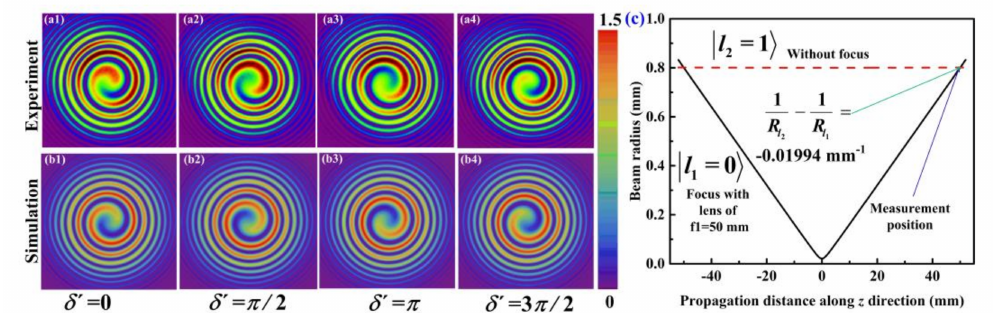
Figure 2. Effect of the effective phase difference δ (cid:48) between the Gaussian beam ( | l 1 = 0 (cid:105) ) and the vortex beam ( | l 2 = 1 (cid:105) ) on the lobe direction. Images ( a , b ) show interference patterns; Row ( a ) shows the experimental results, and row ( b ) shows the simulation results. The color bar is shown for numerical simulation. ( c ) shows the beam radii of two interference beams versus the propagation distance.